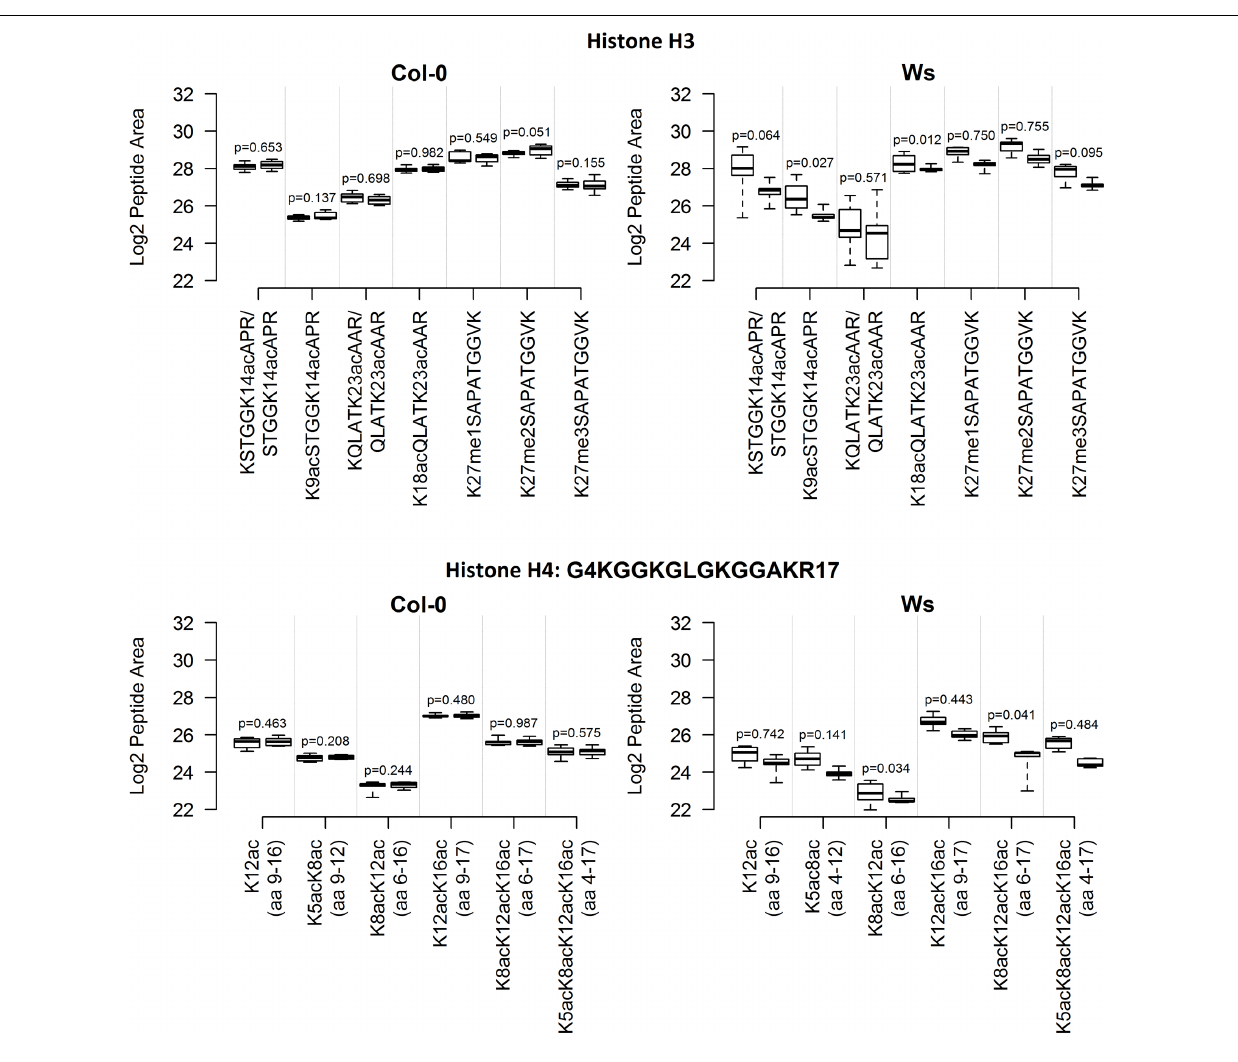
FIGURE 1 | Inter-plant variability of selected histone mark levels in A. thaliana Col-0 and Ws ecotypes grown from seeds collected from a single parent plant (Single) and a set of parent plants (Mixed), after aggregation of technical replicates. For each ecotype and histone, the distribution of normalized log2-transformed peptide precursor XIC peak areas is represented by a pair of boxplots: Mixed (left) and Single (right) . Abundances of peptides with missed enzyme cleavages (e.g., QLATKAAR and KQLATKAAR) were summed. The boxplots show extremes, interquartile ranges and medians obtained from analyses of samples of eight plants (averages of three technical batches). Differences in variances in abundances of individual peptides between Mixed and Single samples were compared by F -tests, p -values are